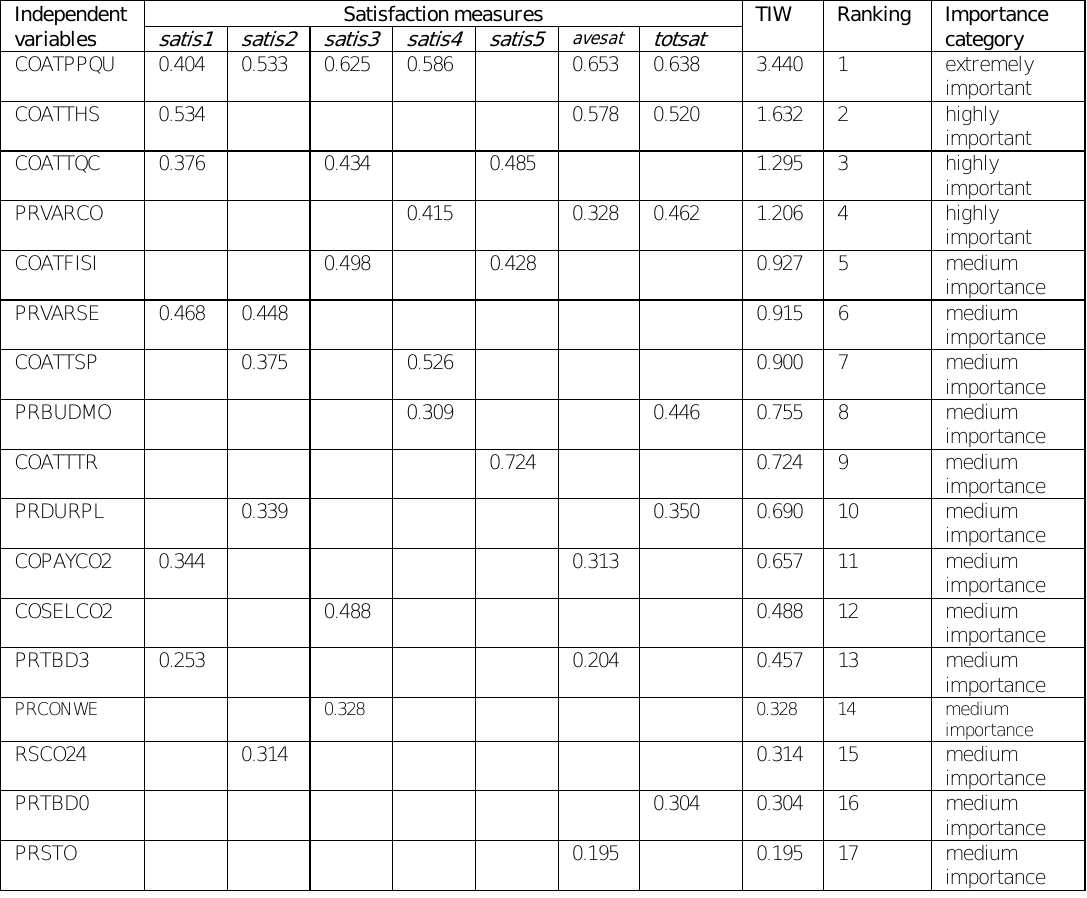
Table 5: Summary of independent variables' total importance weights (TIWs) derived from clients' assessment of contractor